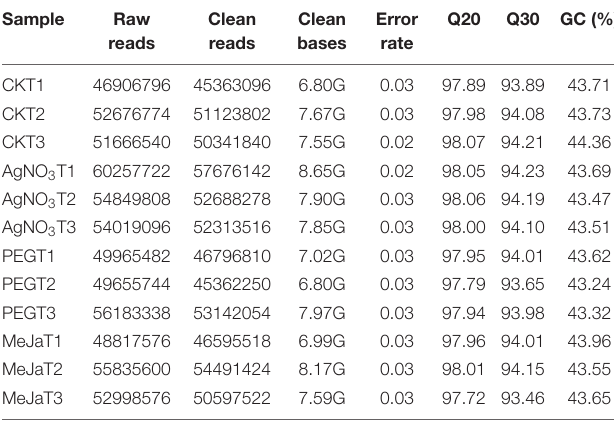
TABLE 2 | Summary of the Illumina sequencing